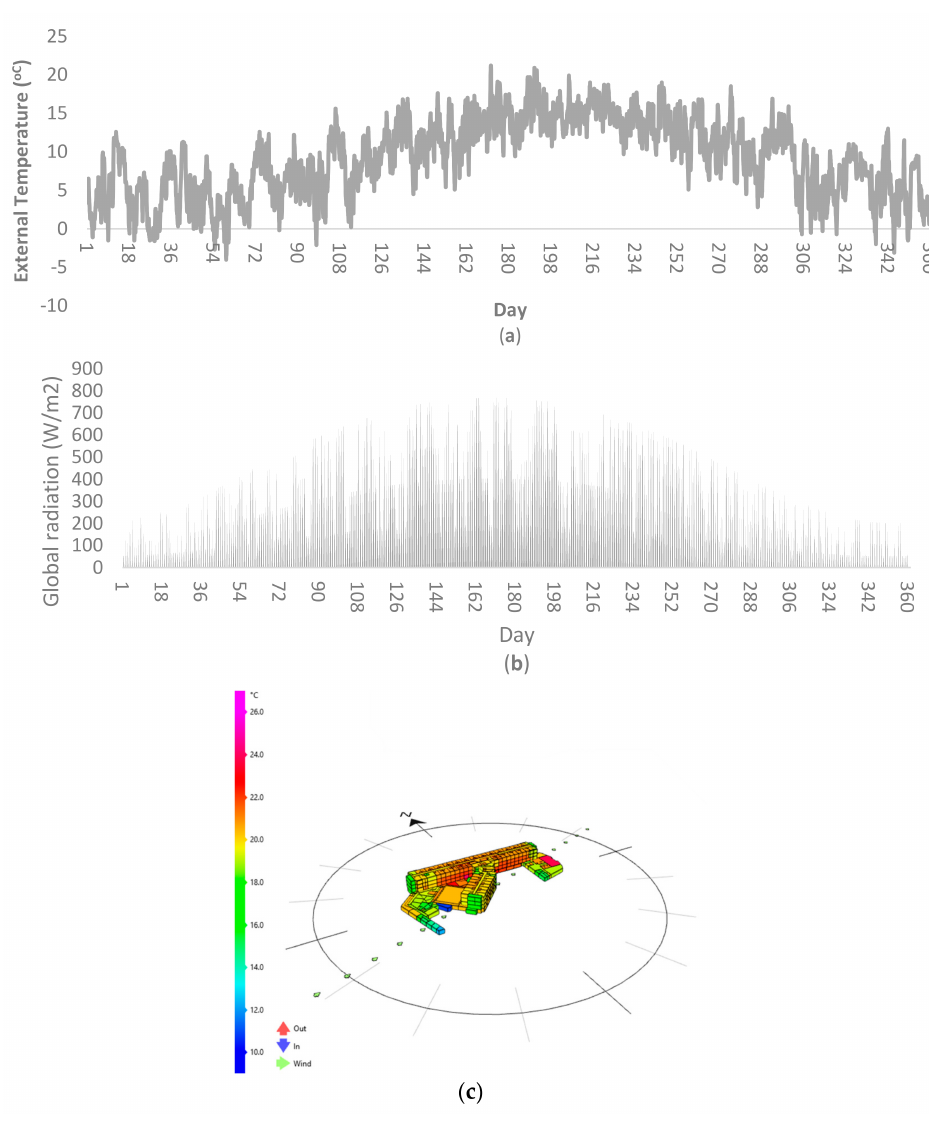
Figure 2. ( a ) External temperature and ( b ) global solar radiation of the simulation weather data, and ( c ) 3D visualisation of the resultant temperature on the building case study. Table 1. Summary of the modelling and simulation